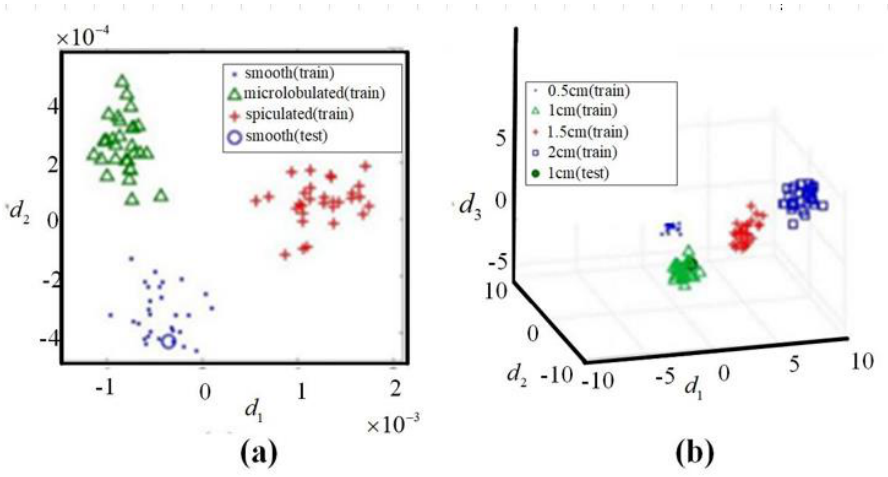
Figure 17. The classification results of the morphological characteristics of a breast tumor. ( a ) Shape. ( b ) Size.